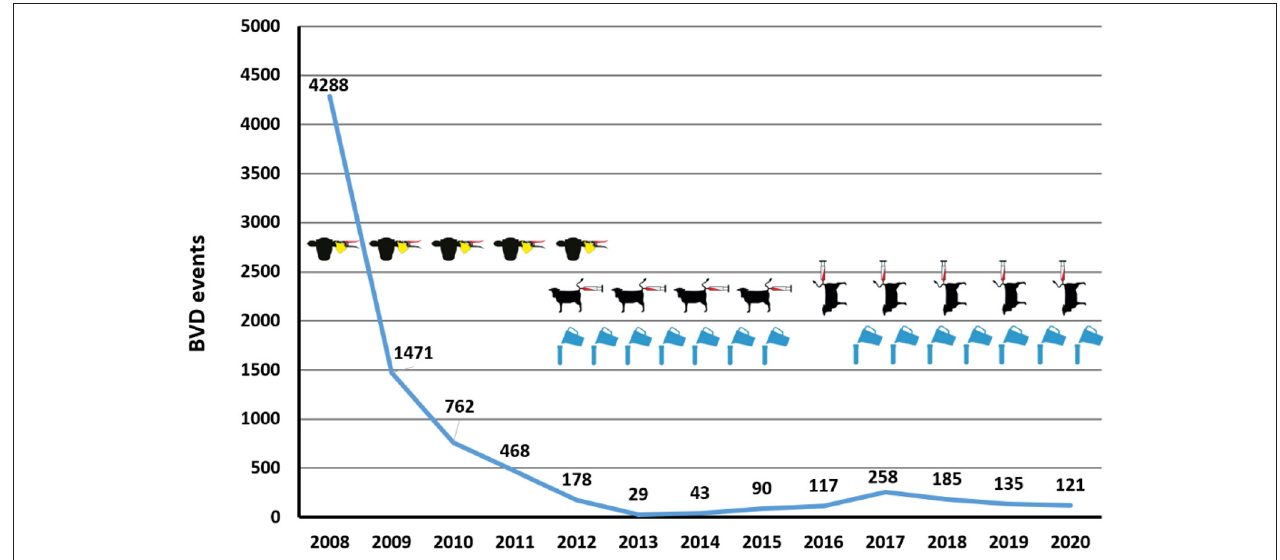
FIGURE 2 | Number of yearly BVD events between 2008 and 2020 and method of BVD surveillance. The number of BVD events (detection of one or more PI animals in a previously BVD-free herd) (y-axis) per year (x-axis) are indicated (blue line with numbers indicated above). The surveillance mode applied in these years is indicated: (i) population screening in 2008 followed by yearly virological testing of all newborn calves (symbol: cattle head with ear tagging); (ii) spot tests by blood samples (symbol: cow with syringe) from living bovines sampled on farm (horizontal symbol) and mainly from slaughtered bovines (vertical symbol); (iii) bulk milk testing (symbol: blue